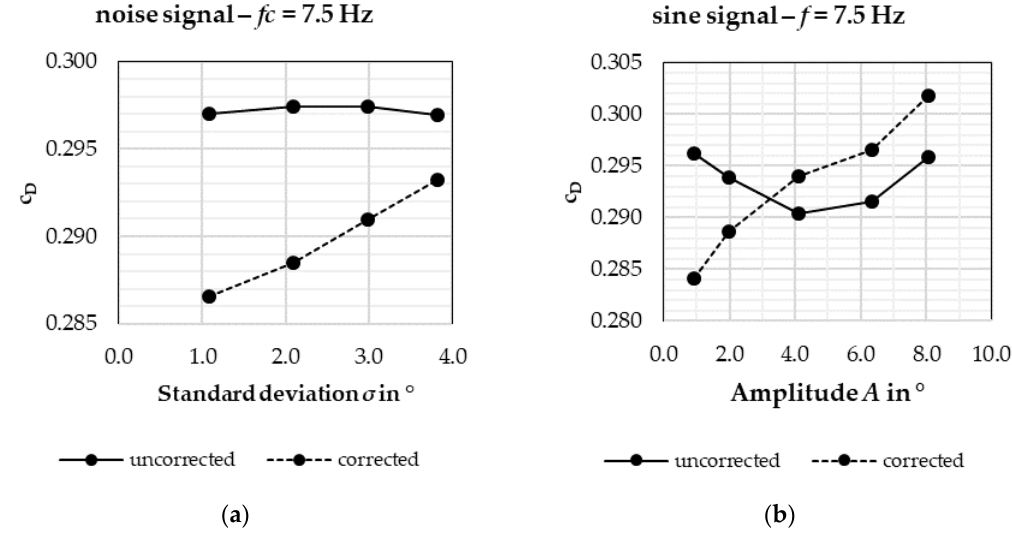
Figure 12. Drag development of the DrivAer notchback over yaw magnitude, uncorrected vs. corrected, for ( a ) noise signals and ( b ) sine signals.